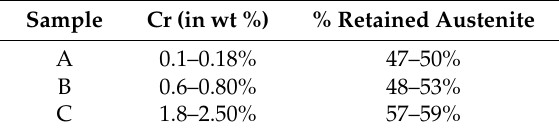
Table 1. High carbon martensitic steels with different chemical